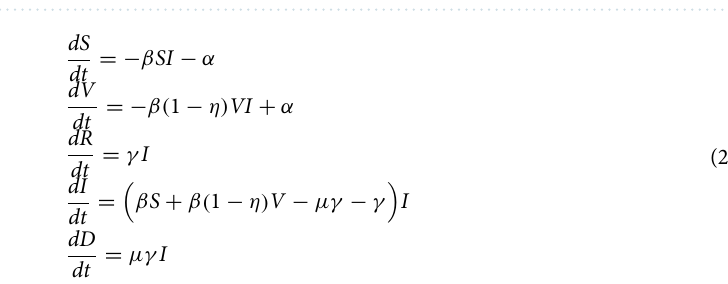
Figure 7. ( a ) SIRDV compartment model with susceptible ( S ), vaccinated ( V ), infectious ( I ), recovered ( R ), and deceased ( D ) populations. Flow between between compartments is shown with arrows. ( b ) Description of model parameters. ( c ) and ( d ) Show variations in disease transmission rate β , due to social response to infectious and vaccinated populations. ( c ) β for a range of level of caution factor d I (100, 200, 400), and ( d ) β for a range of sense of safety factor d V (1, 2,